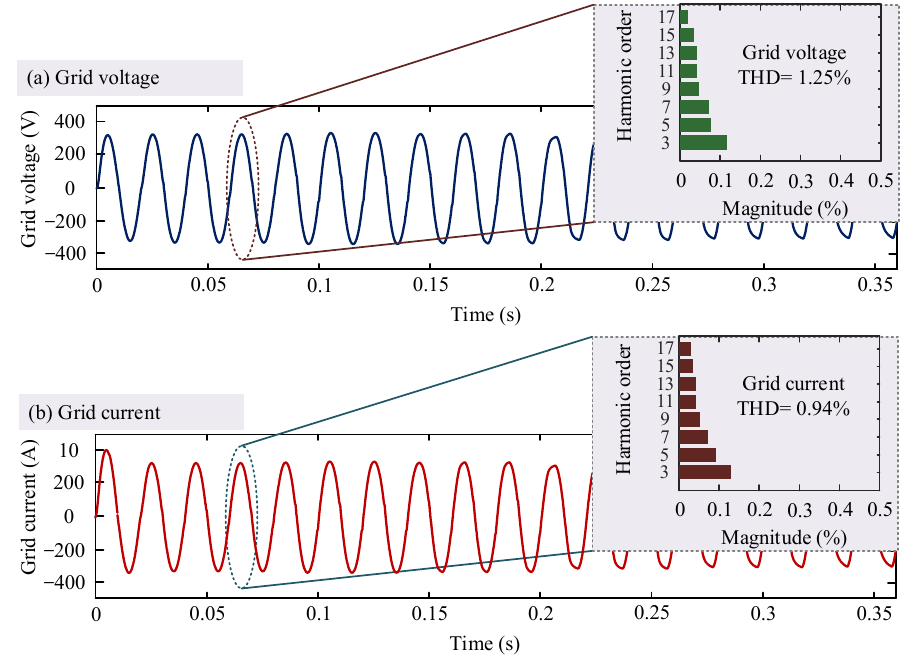
Figure 11. Grid voltage and current waveforms with the proposed transformer-less inverter and its harmonic counting after varying the current reference in the current controller: ( a ) grid voltage and its harmonic counting, ( b ) grid current and its harmonic counting.